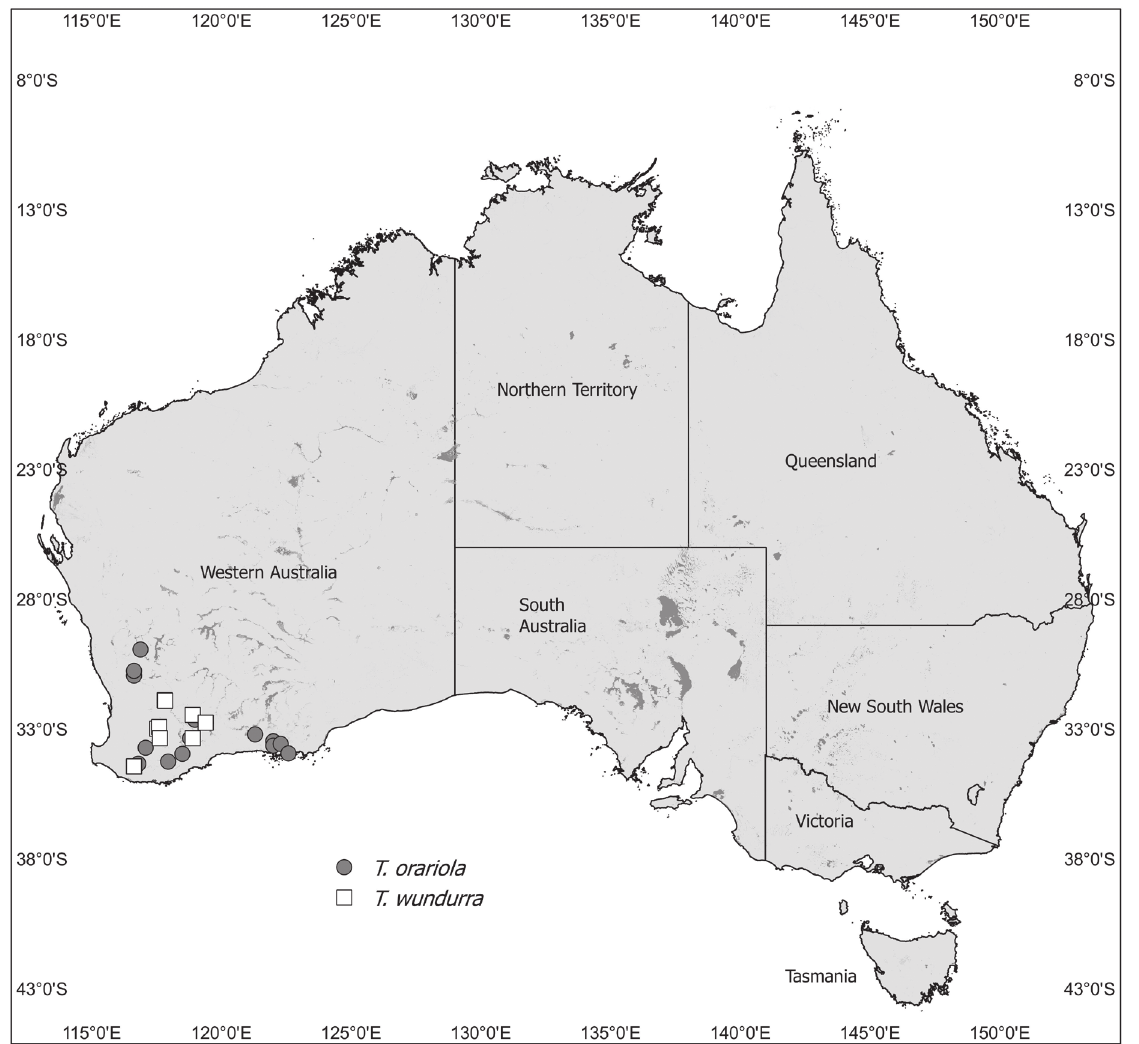
Fig. 13. Tetralycosa orariola sp. nov. and T. wundurra (McKay, 1979) comb. nov., distribution records in